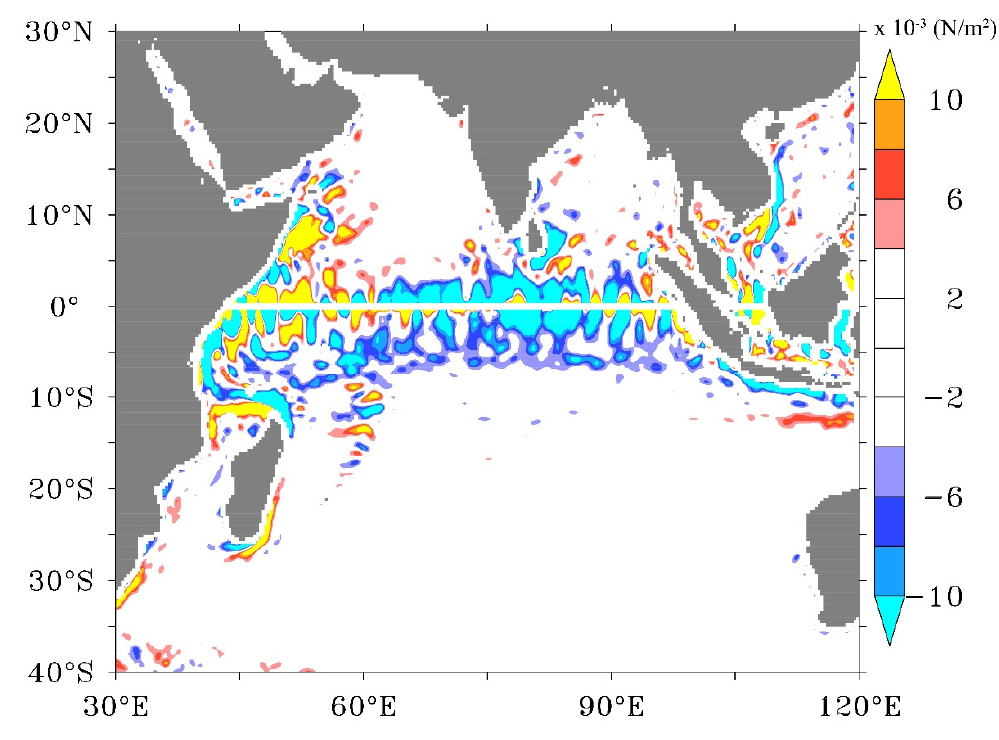
Figure 5. Average annual difference between the wind stress curl estimated with and without the inclusion of surface currents ( τ Cur − τ no-Cur ) during 2007–2020.